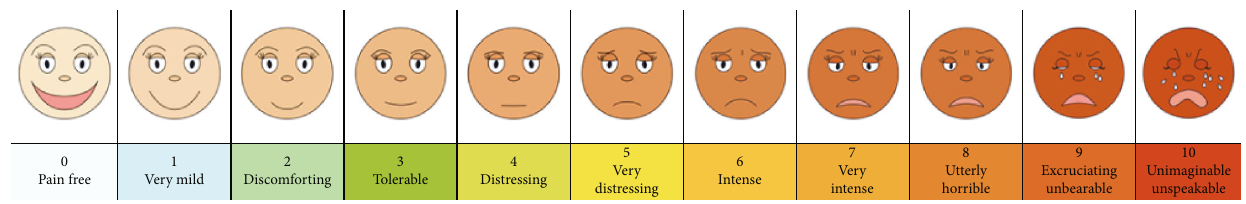
Figure 3: Format of the combined questionnaire.